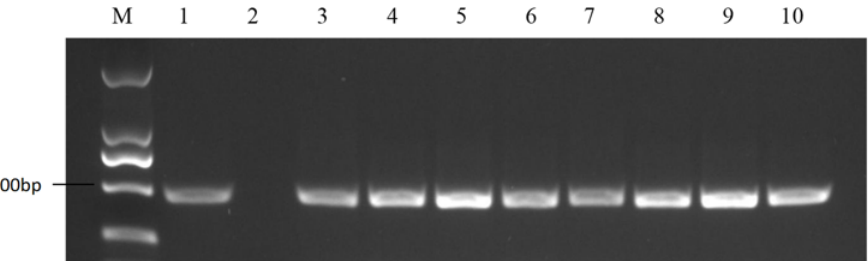
Figure 2. PCR amplification of PKC6F/PKC6R in cabbages. M represents the DNA Marker 2000; 1 represents the positive control; and 2 represents the negative control. Lanes 3–10 are cabbage mate ‐ rials with class I S ‐ haplotypes.